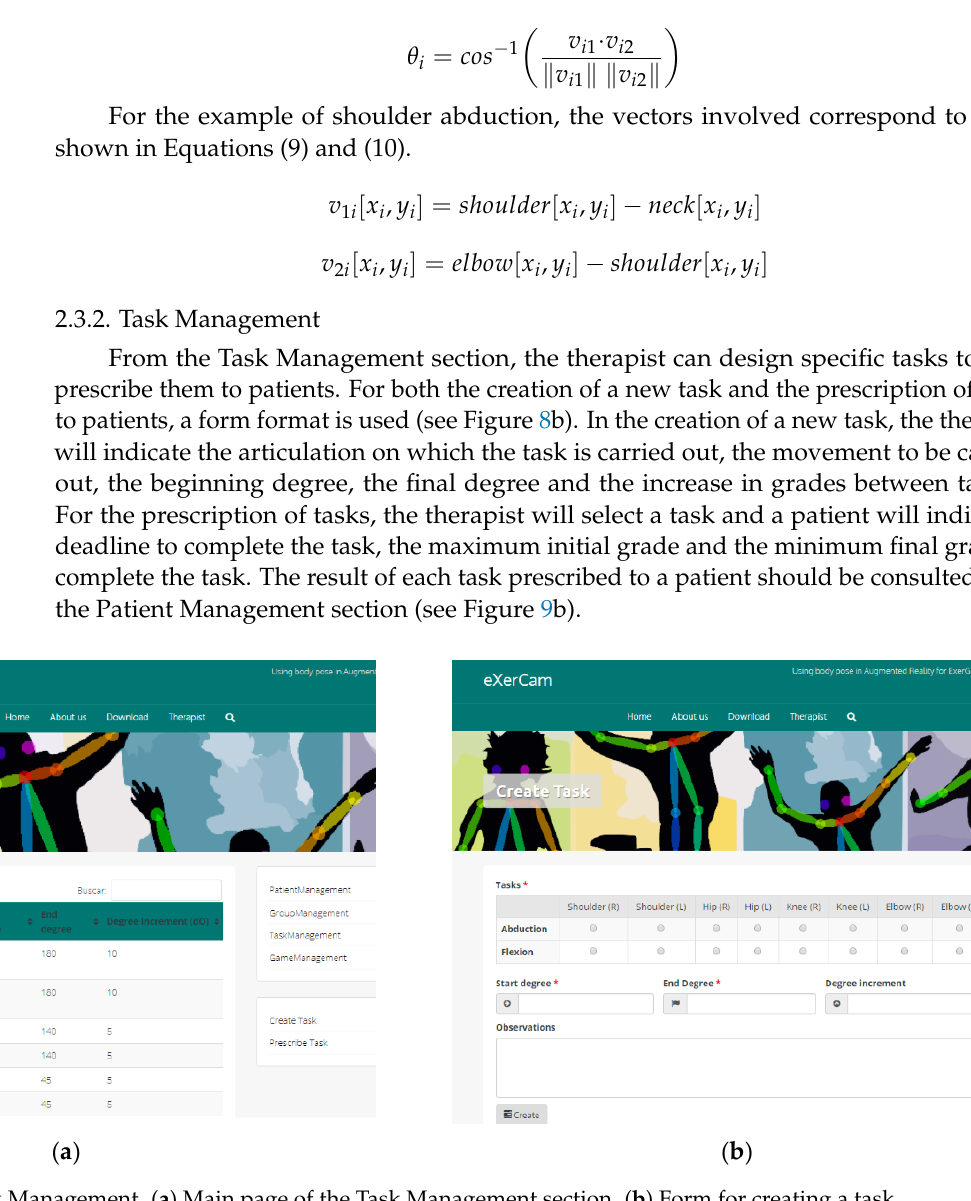
Figure 8. Task Management. ( a ) Main page of the Task Management section. ( b ) Form for creating a task.